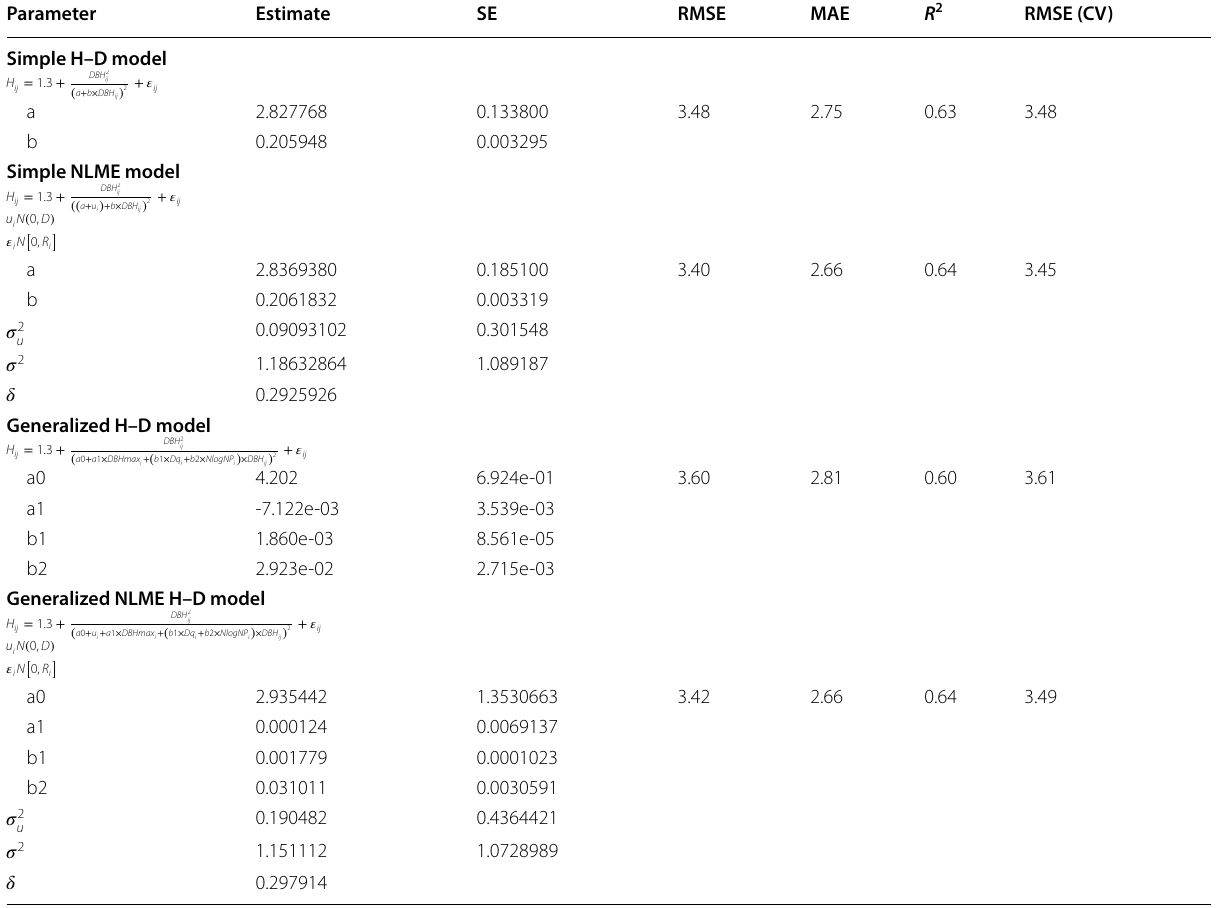
Table 16 Estimated parameters and goodness of fit of the H–D models for N. pumilio fitted to the complete database Parameter Estimate SE RMSE MAE R 2 RMSE